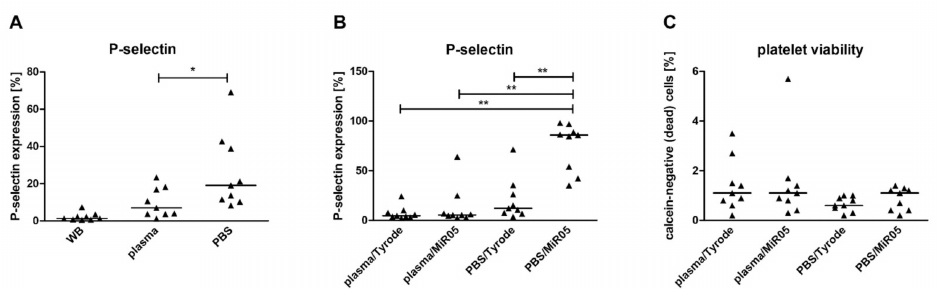
Figure 2. The influence of the method of sample preparation on platelet activation and viability. Data presented as individual data points with medians (horizontal lines); n = 9. ( A ) P-selectin’s presence measured on platelets in whole blood (WB) and on platelets isolated from that blood and suspended in plasma or in PBS (primary platelet suspensions); ( B ) P-selectin expression on isolated platelets suspended in different medium/buffer combinations; ( C ) viability of isolated platelets suspended in different medium/buffer combinations. Significance of differences was estimated with ANOVA for repeated measures with medium type as independent grouping variable ( A ) or with two-way ANOVA for repeated measures with the Tukey’s post hoc test ( B , C ): * p < 0.05, ** p < 0.001. Additional information on the effect of the medium, the effect of the buffer and the effect of the buffer depending on the medium are presented below: ( A ) p < 0.001 for the effect of isolation (WB vs. platelets resuspended in medium, plasma and PBS), ( B ) p < 0.001 for the effect of medium, p < 0.01 for the effect of buffer, p < 0.001 for the medium-dependent buffer effect; p < 0.05, plasma vs. PBS, p < 0.001, plasma vs. PBS/MiR05, PBS vs. PBS/MiR05, ( C ) ns. for the effect of medium, ns. for the effect of